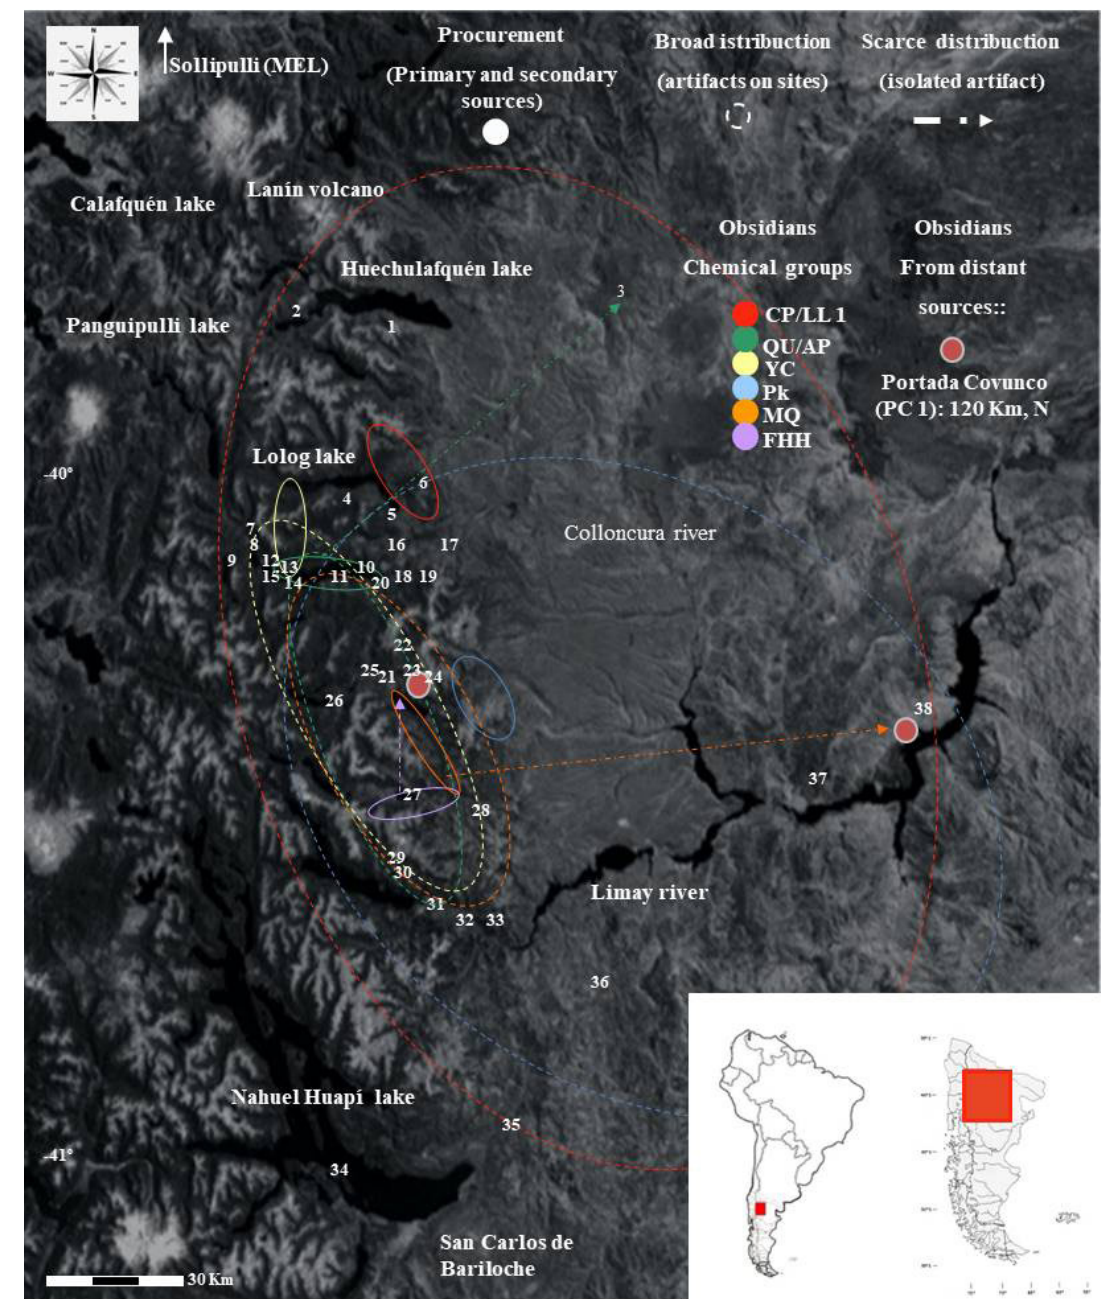
Figure 1. Location of sources and archaeological distribution of chemical groups from southern Neuquén (site references